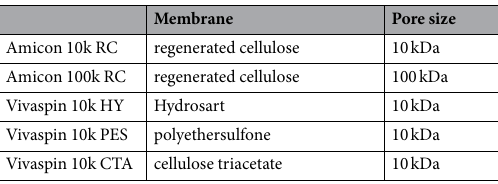
Table 1. Characteristics of implemented centrifugal